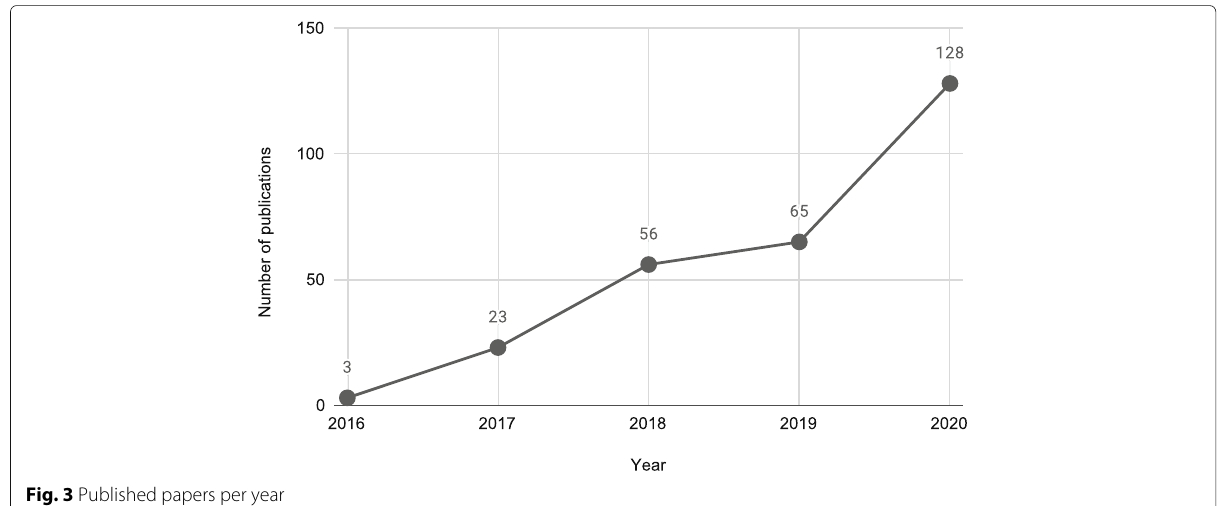
Fig. 3 Published papers per year